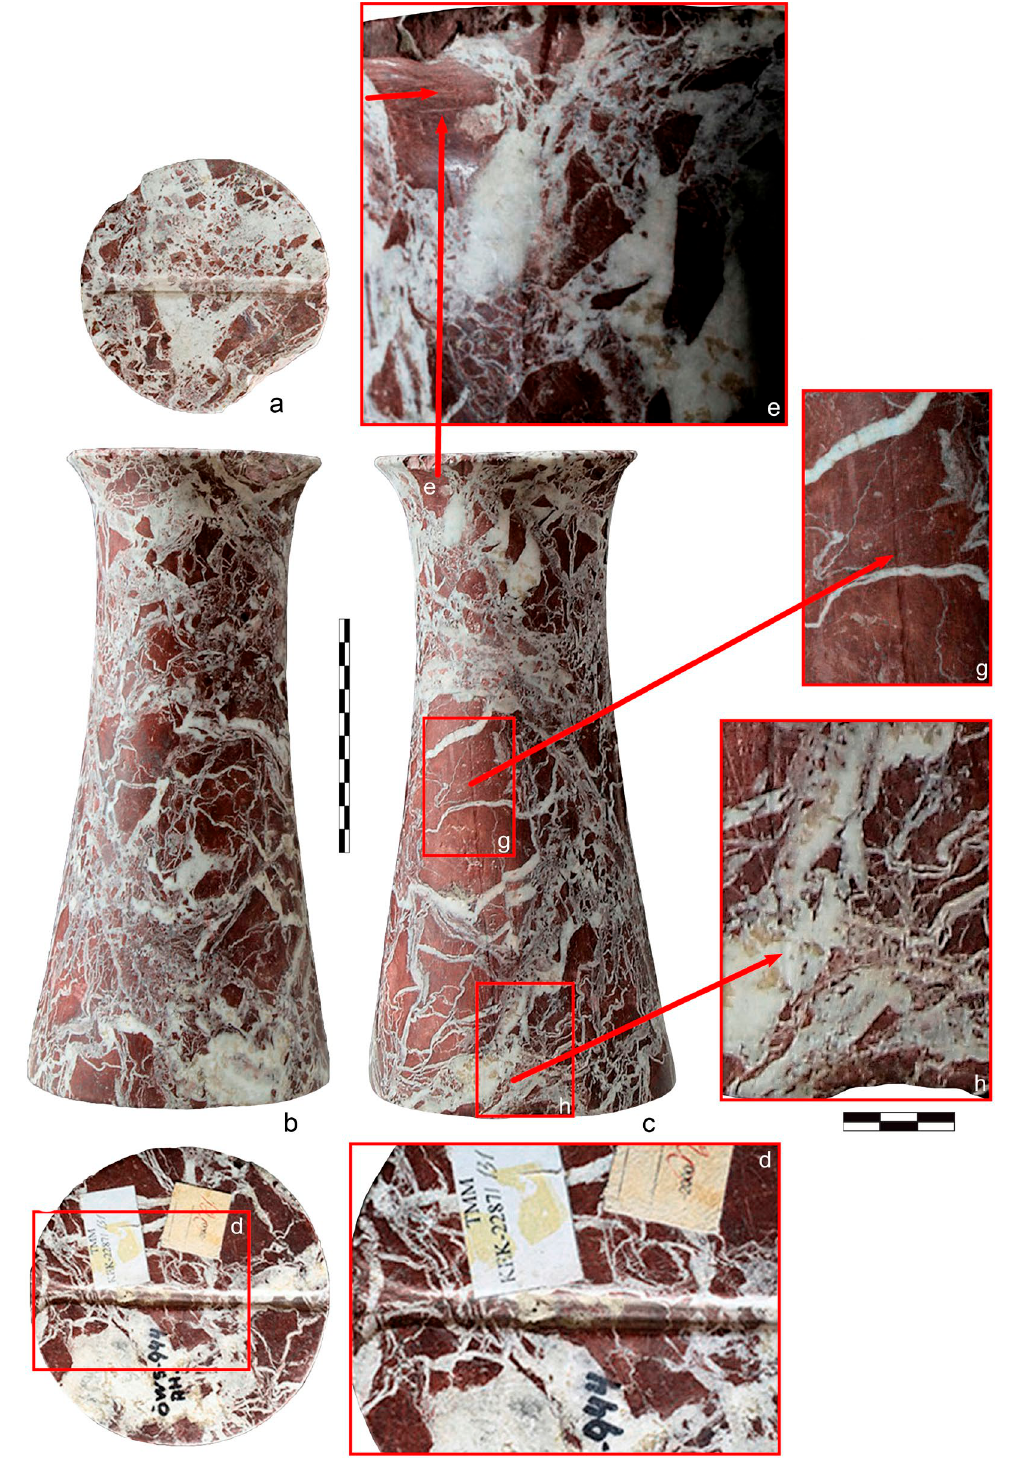
Figure 18. Truncated-conical miniature column with a hat with circular traces of processing (from the depositories of the National Museum of Turkmenistan, Ashgabat): a. top base; b, f. side; c. bottom base; d. traces of sawing the groove; e. traces of grinding; g, h. trace from the marking tool. Scale bar is 10 cm long, separated into 1 cm segments, except for h, which is 3 cm long, separated into 1 cm